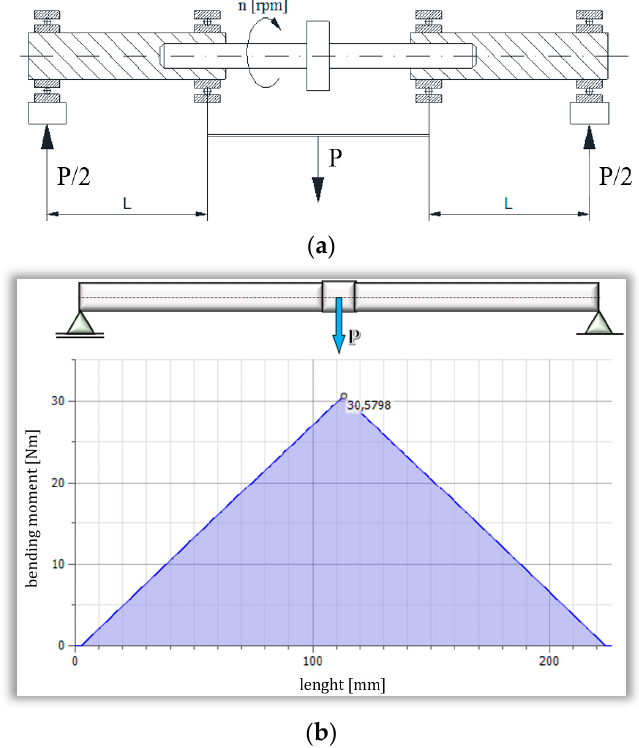
Figure 3. ( a ) Method of attaching the sample, ( b ) Bending moment distribution. Table 3. Wear test parameters. Parameter Value Loading force 550 N Maximum bending moment 30.6 Nm Number of sample revolutions 1360 rev./min Maximum number of cycles 1,000,000 Stress amplitude for ø 12 mm 162 Mpa Stress amplitude for ø 13 mm 128